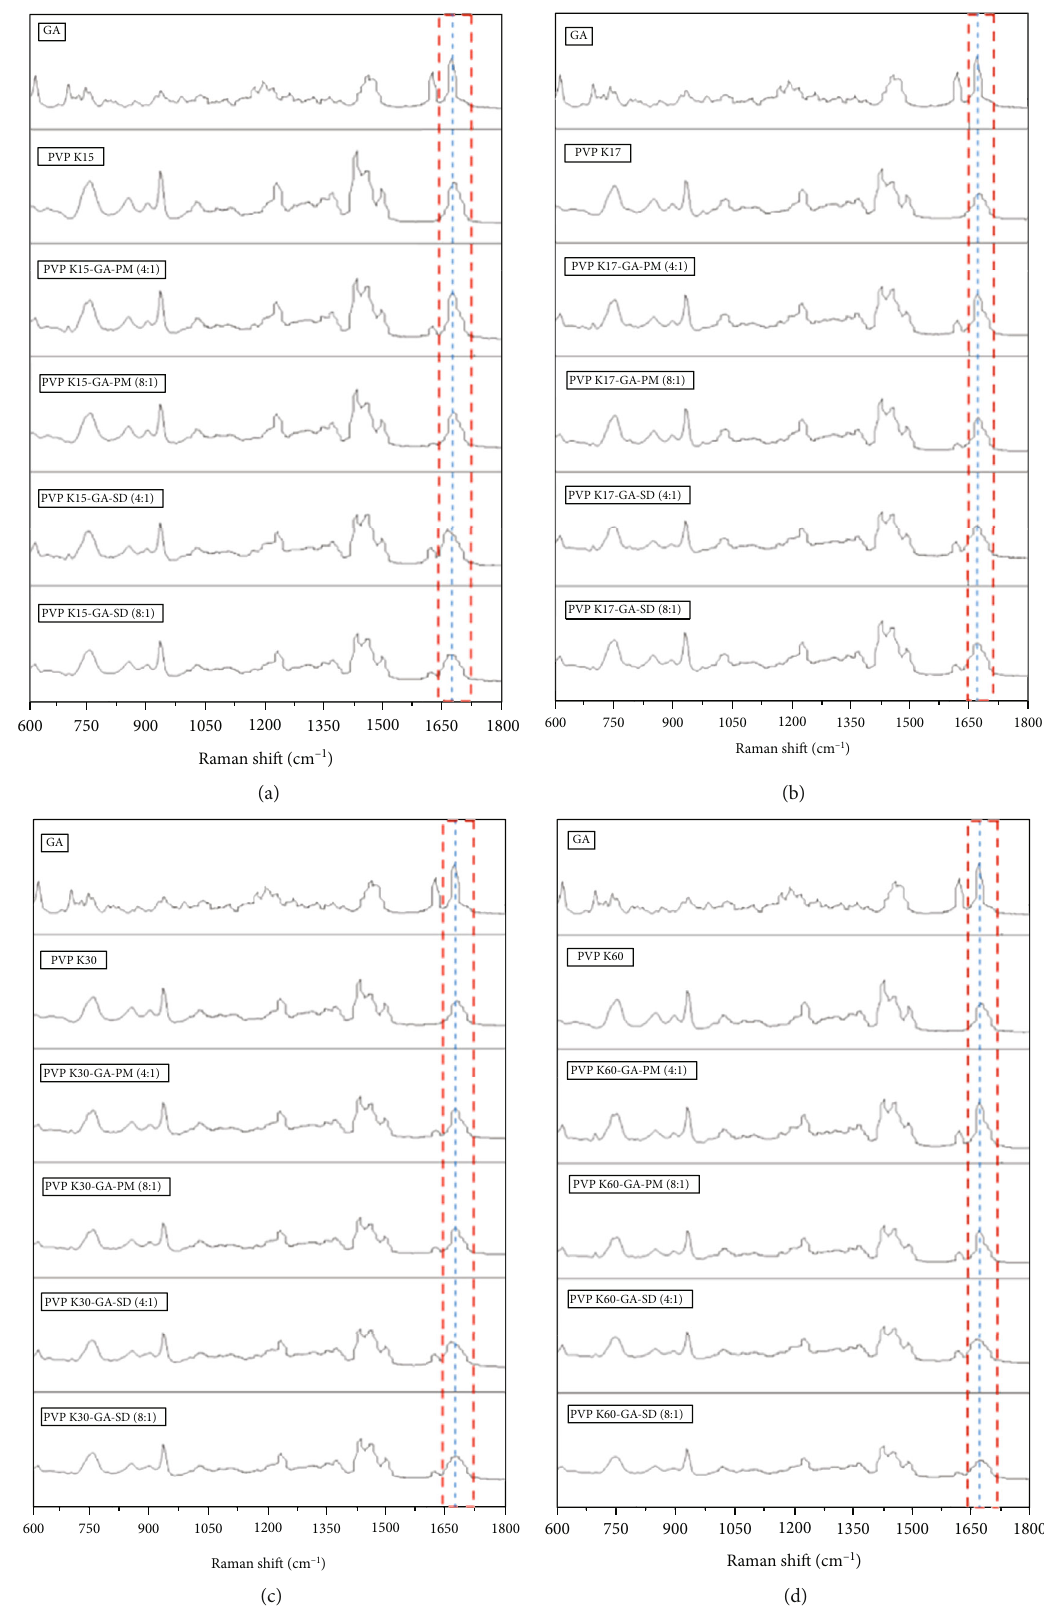
Figure 7: Raman spectra of SDs and PMs of GA prepared using (a) PVP K15, (b) PVP K17, (c) PVP K30, and (d) PVP